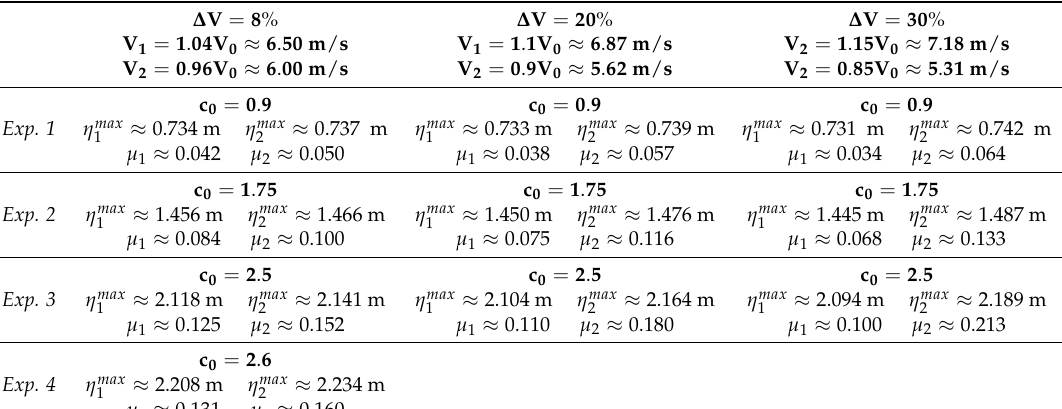
Table 1. Parameters of left (subscript 1 ) and right (subscript 2 ) placed breathers for which we study the collision